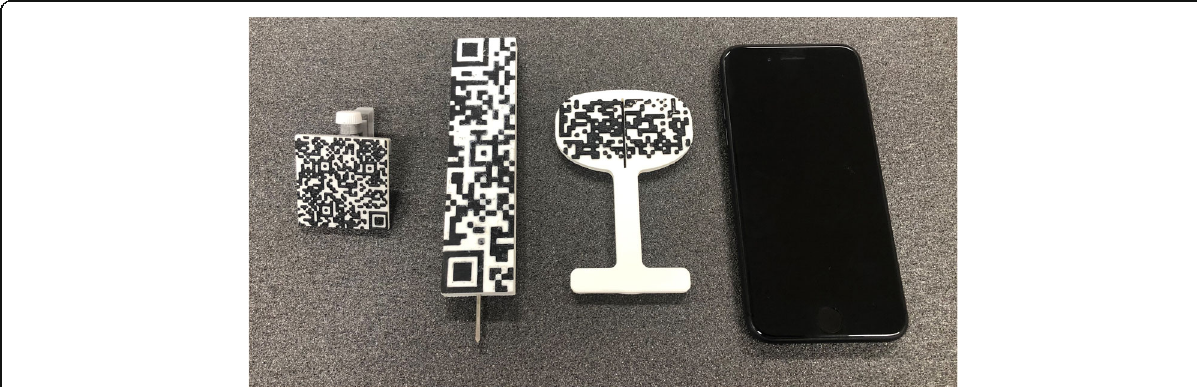
Fig. 2 Markers and smartphone used in the AR-KNEE system. From left to right: guide marker, pointer, oval marker, and smartphone. The camera of the smartphone recognizes two-dimensional bar codes of guide marker, pointer and oval marker when using the AR-KNEE system. Note that the oval marker has a slit that allows the surgeon to mark the tibial rotational alignment reference line